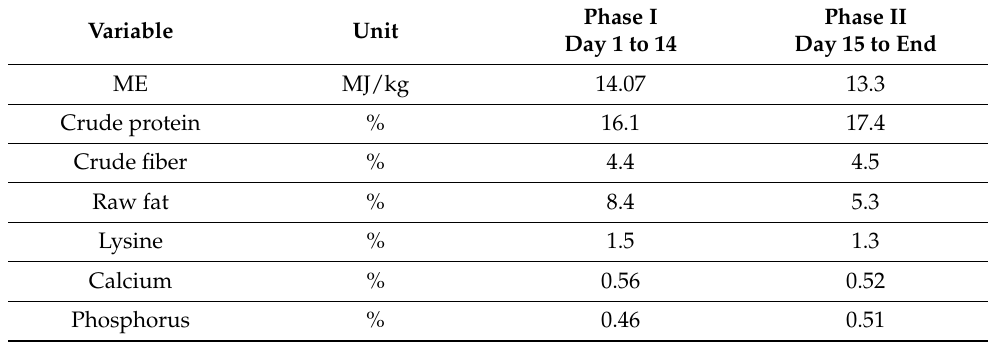
Table 1. Composition of the two-phase feeding regime. Based on the air-dry fresh mass of the feed.